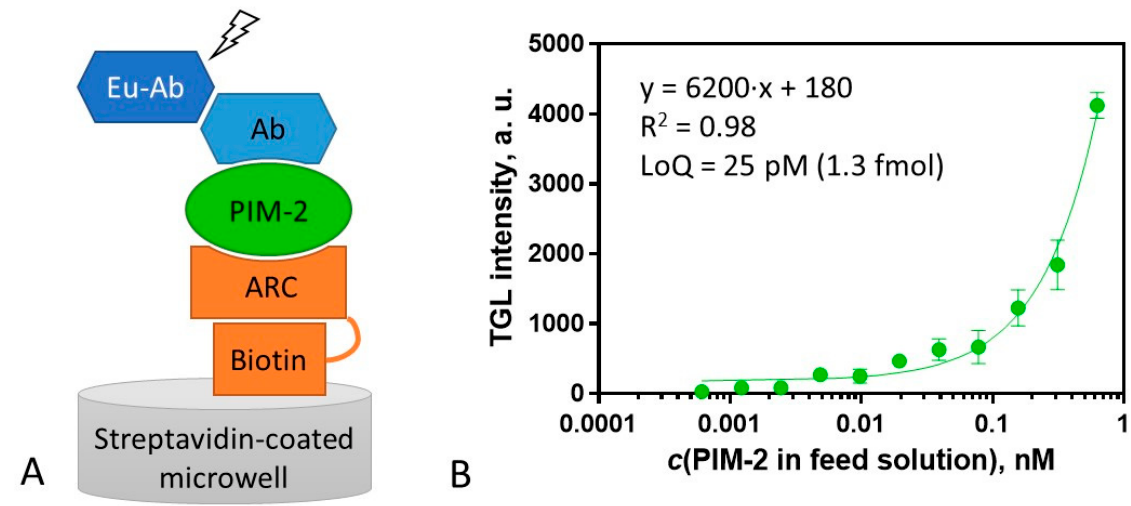
Figure 4. Scheme and calibration curve of the assay for measurement of concentration of PIM-2. ( A ) Scheme of the assay format for PIM-2 measurement. PIM-2 is bound to the ARC-2073 functionalized surface (step 1), the solution of the primary antibody (Ab) is added (step 2), and Eu chelate-labeled secondary antibody (Eu-Ab) is added (step 3). ( B ) Calibration curve for PIM-2 analysis (immobilized ARC-2073 (4 pmol), detection with D1D2 (84 fmol) and G0506 (110 fmol)). TGL intensity was measured with excitation at 330 (60) nm; emission was detected at 590 (50) nm (integration from 80 to 1000 µ s). All measurements were performed in triplicate, and the variance was estimated as SEM.